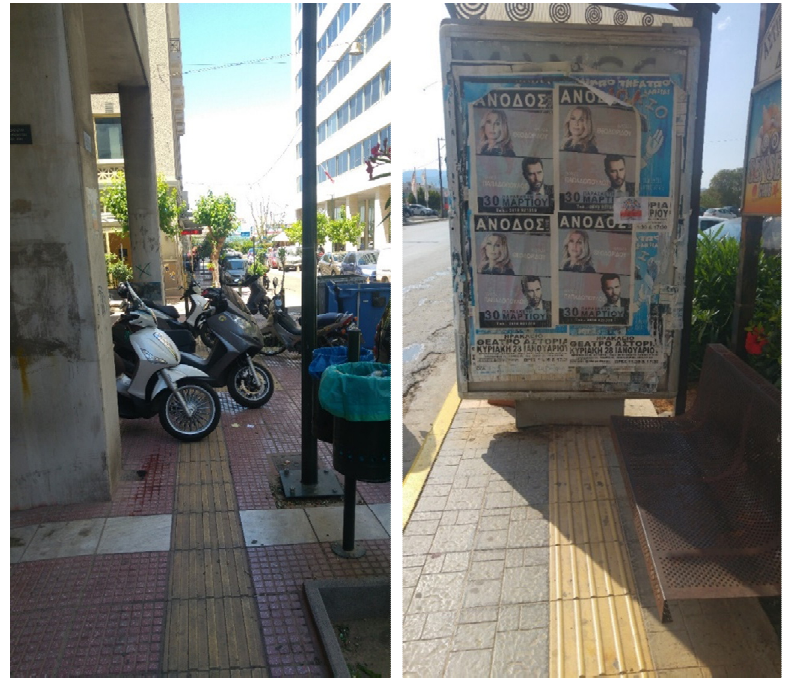
Figure 9. Examples of large width obstacles.